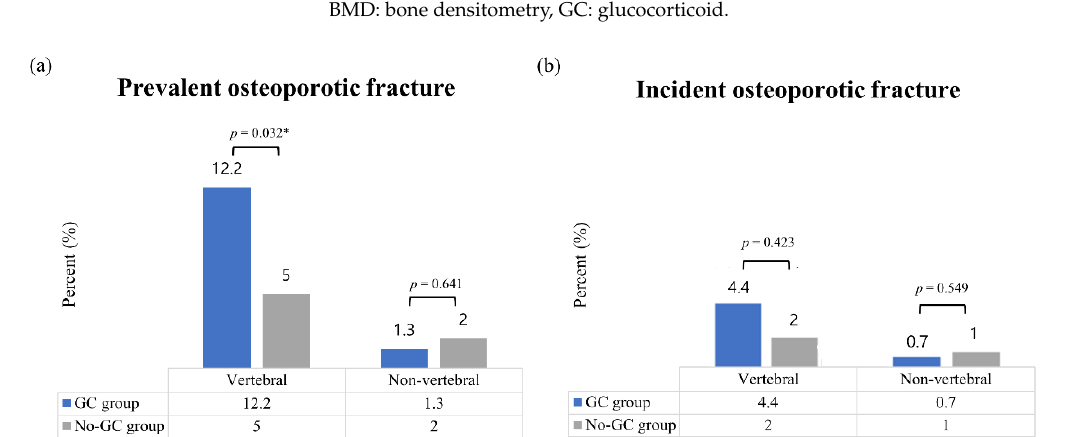
BMD: bone densitometry, GC: glucocorticoid.